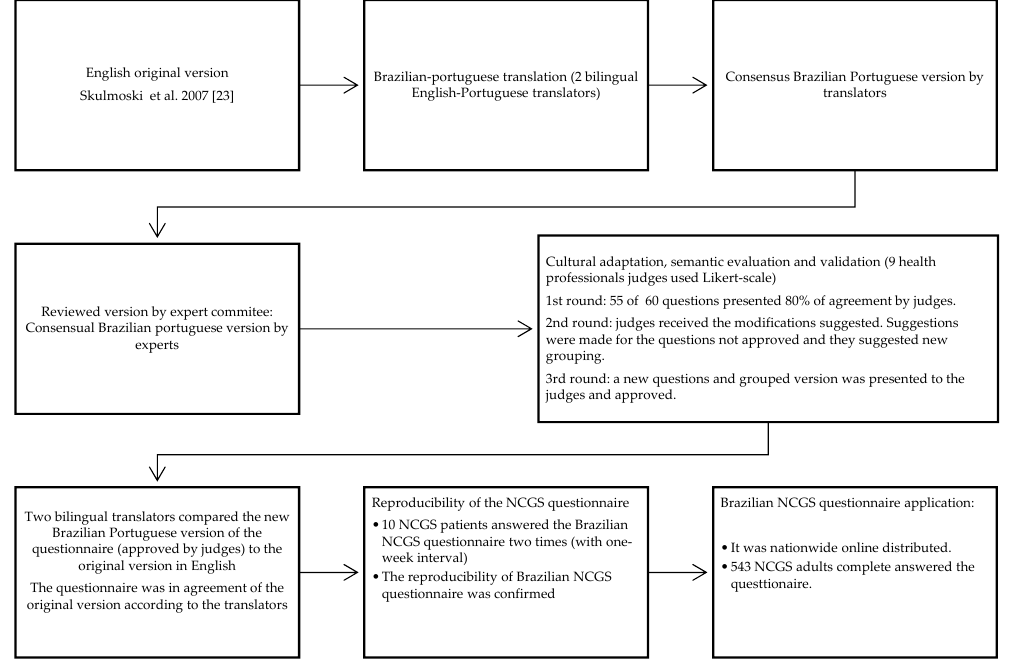
Figure 1. Sequential stages followed in the process of translation, cultural adaptation, and validation of the Brazilian non-celiac gluten sensitive (NCGS) questionnaire.